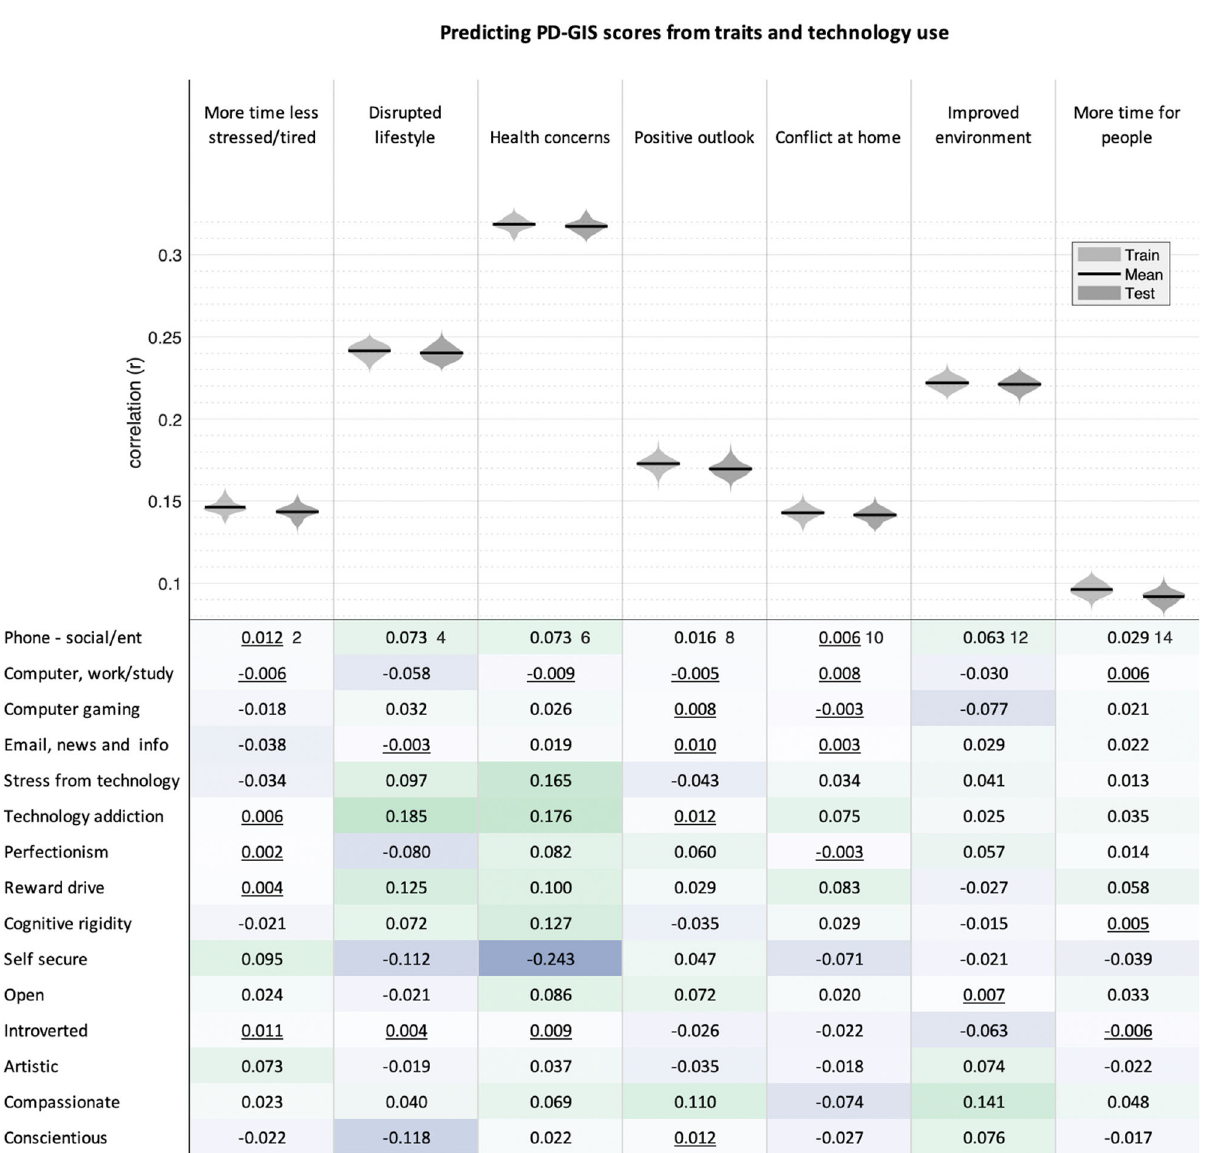
Fig. 10 Correlation of trait and technology with PD-GIS component scores. Top. Linear modelling showed that collectively emotion, compulsivity and technology-use traits predict substantial variance (all p < 0.0001 two tailed and FWE corrected for multiple comparisons) in dimensions of self-perceived pandemic impact, particularly for health concerns. Violin plots show the distributions of Pearson ’ s correlations for 100 models trained on random 50% subsets of the data (light grey) and the correlations of predicted vs observed values when those trained models were applied to the remaining 50% of the data (dark grey), to which it was naive, with means highlighted in black. Note the lack of over fi t. Bottom. Bivariate correlations were mostly statistically signi fi cant and generally in the small range. Non-signi fi cant correlations at the two-tailed criterion of p > 0.05 after FWE correction for multiple comparisons are underlined. The strongest relationships were evident for (i) disrupted lifestyle, which correlated positively with technology addiction and reward drive and negatively with self-security and conscientiousness; and (ii) health concerns, which correlated positively with stress from technology, technology addiction, reward drive and cognitive rigidity and negatively with self-security. Source data are provided as a Source data fi